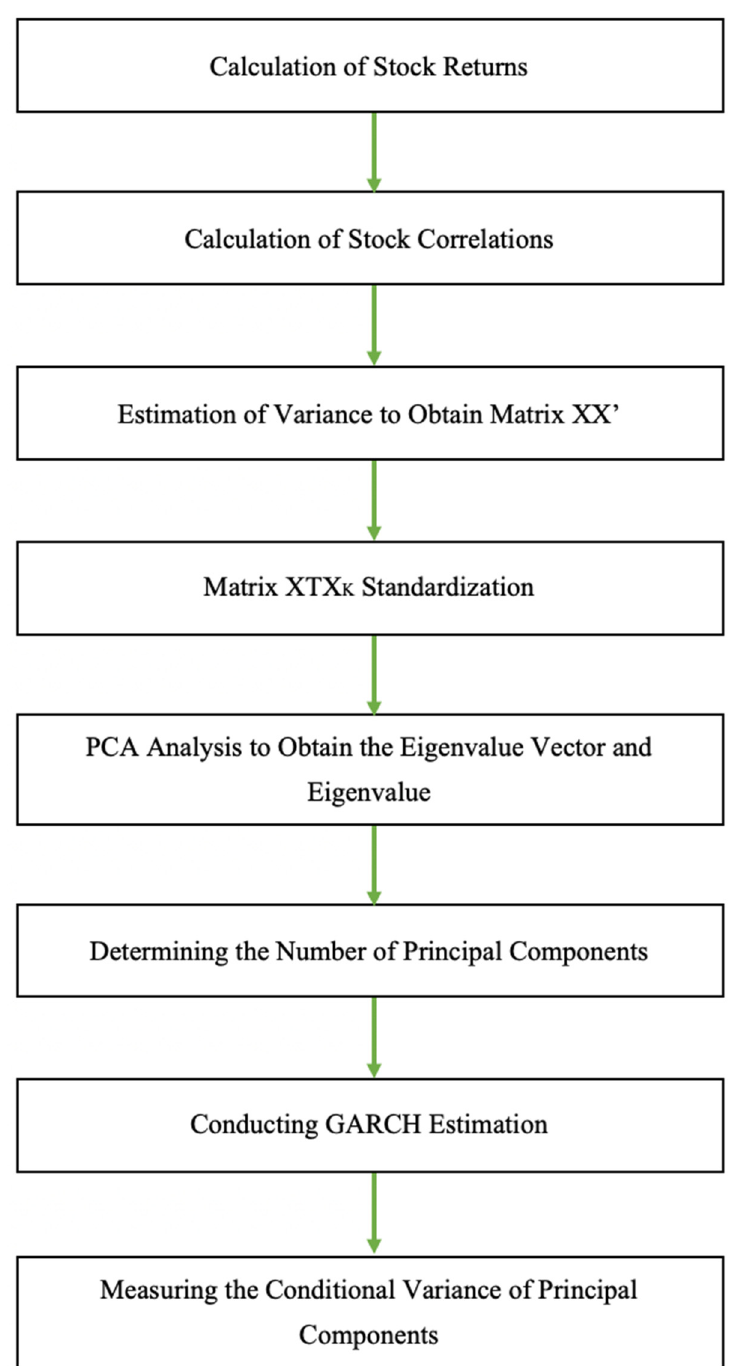
Figure 1. Research flow diagram.